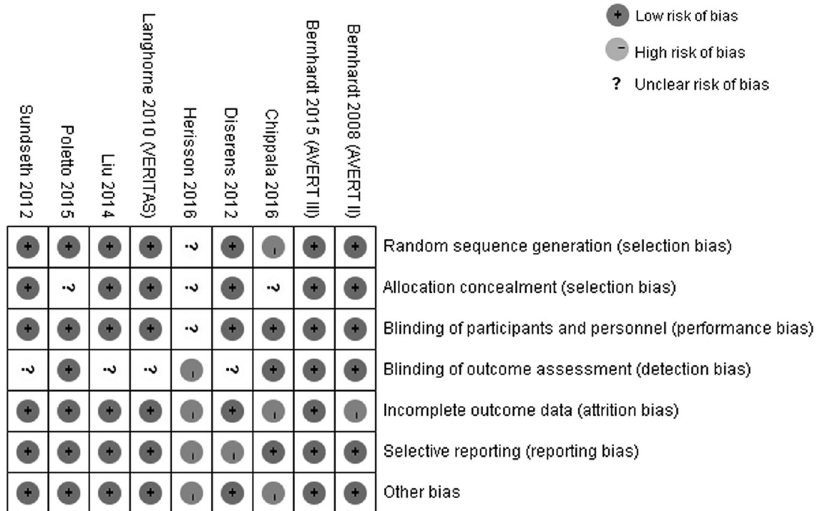
Figure 5. Risk of bias: A summary table for each risk of bias item for each